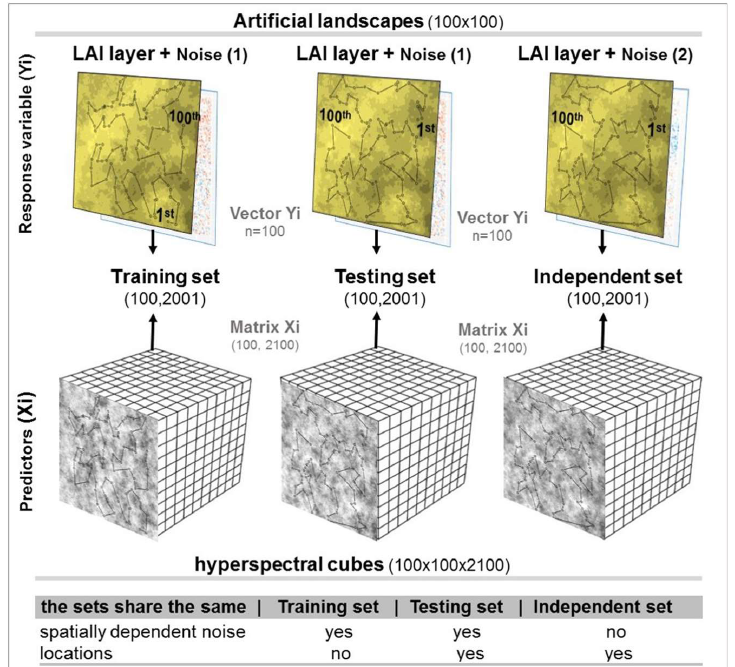
Figure 3. Sampling spectra and Leaf Area Index (LAI) values for model training and validation sets. The testing sets share the same spatial dependent noise as the training sets, but sample at different locations and sequence. The independent sets present the same location as the testing sets but with different spatially dependent noise. Those datasets are publicly accessible at DOI: 10.4121/uuid:2016d562-cf6e-4060-ac13-5db9477b6512.